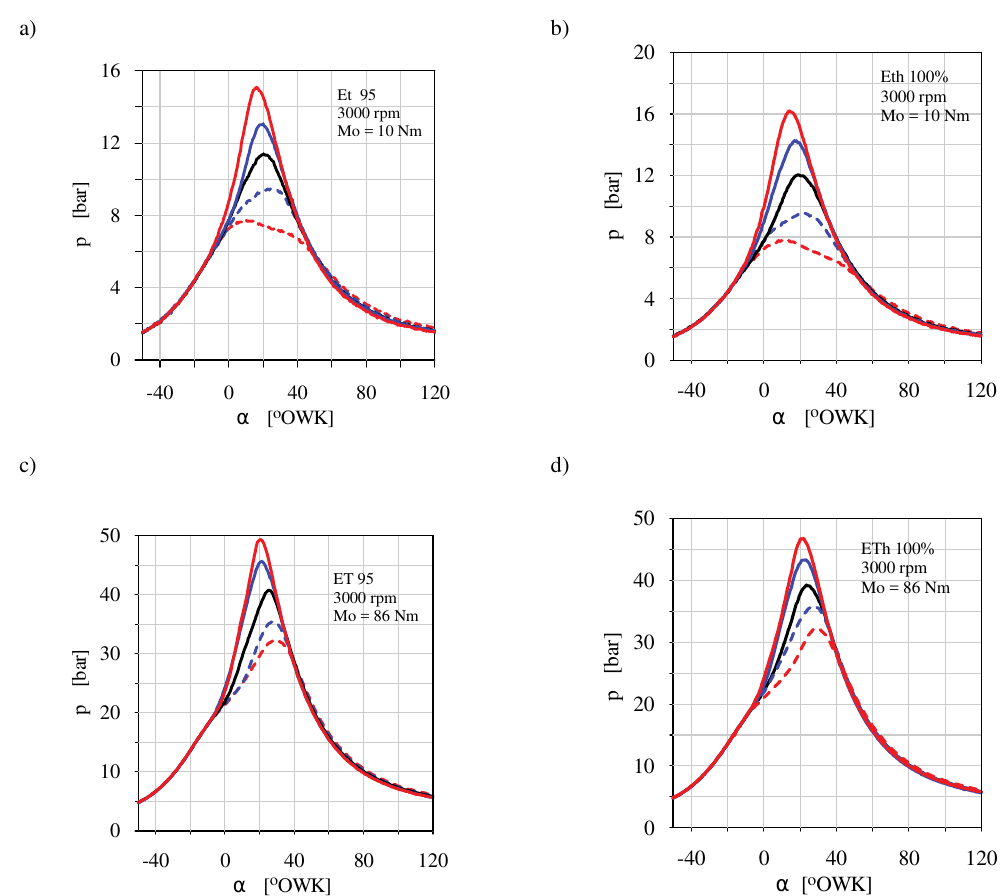
Fig. 10. Comparison of pressure runs in cylinder of the engine run on gasoline and ethanol: rotational speed 3000 rpm, minimal load10 Nm and maximal load 86